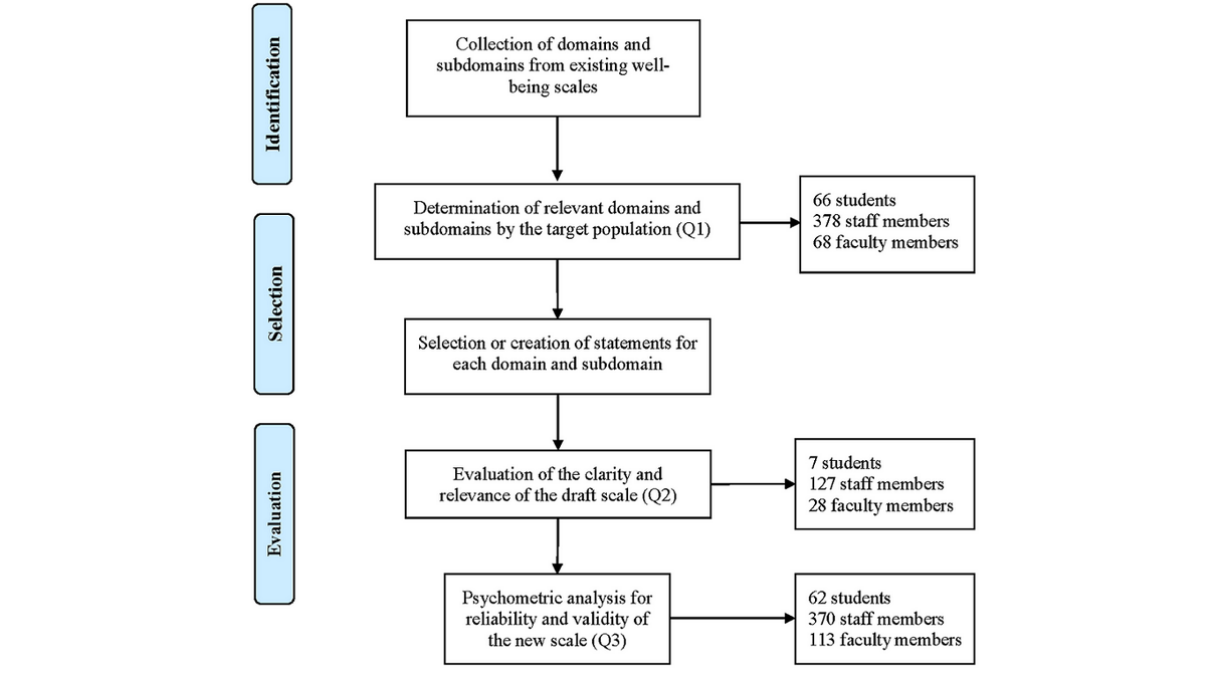
Figure 1. Flowchart of the design and evaluation of the well-being